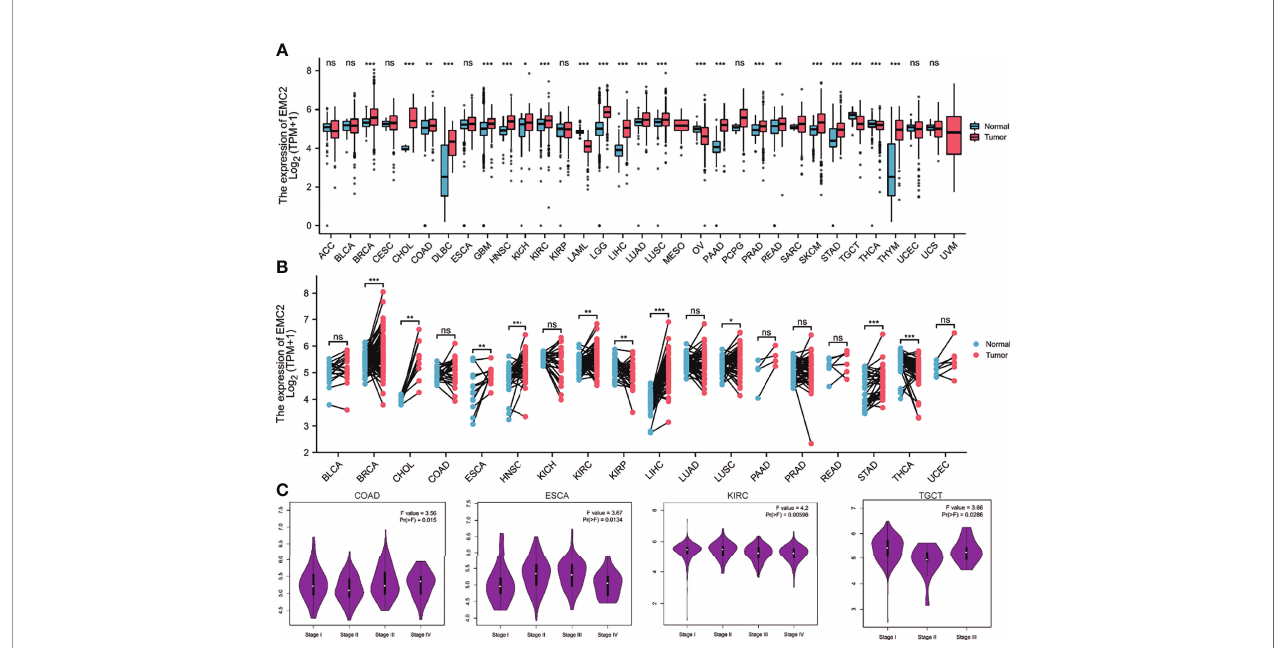
FIGURE 1 | EMC2 expression analysis in multiple cancers. (A) The expression of EMC2 in 33 types of human cancer based on the TCGA (cancer samples) and GTEx (normal tissues of unpaired samples) databases. (B) EMC2 expression in paired samples obtained from TCGA. (C) Based on the TCGA data, the expression levels of the EMC2 were analyzed by the main pathological stages (stage I, stage II, stage III, and stage IV) of COAD, ESCA, KIRC, and TGCT. Log2 (TPM + 1) was applied for log-scale. ns, not signi fi cant; *P < 0.05; **P < 0.01; ***P <